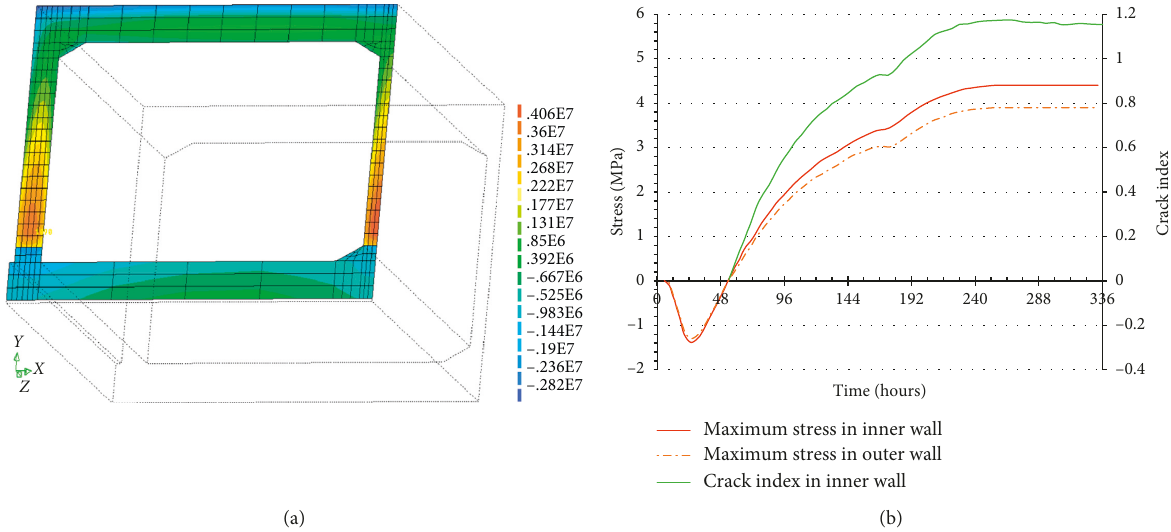
Figure 7: Calculated stress developments of SV40 concrete: (a) stress contour (336 h after casting); (b) stress developments in the inner and outer